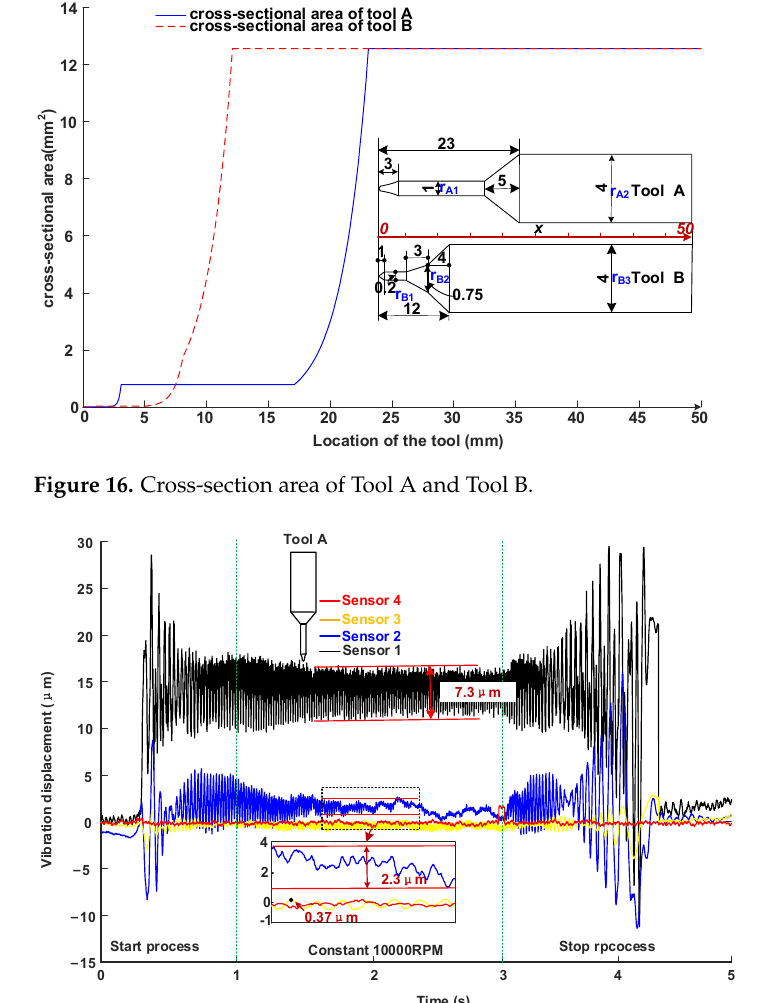
Figure 17. Vibration propagation of Tool A in the start–stop process.